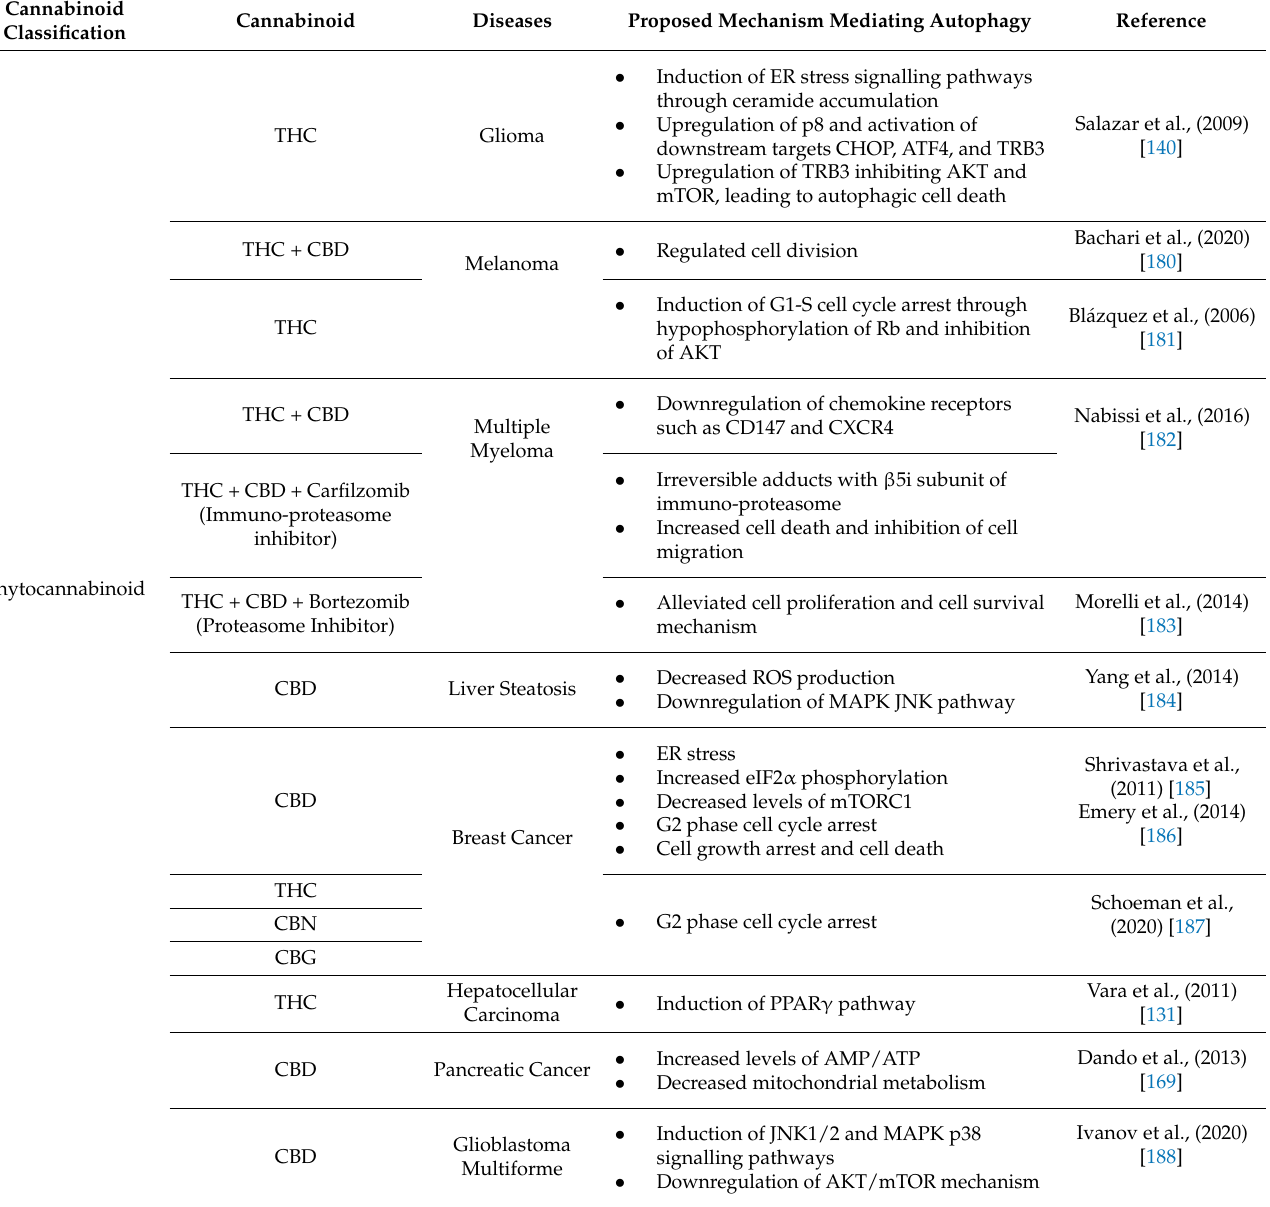
Table 1. Cannabinoid-Induced Autophagy in